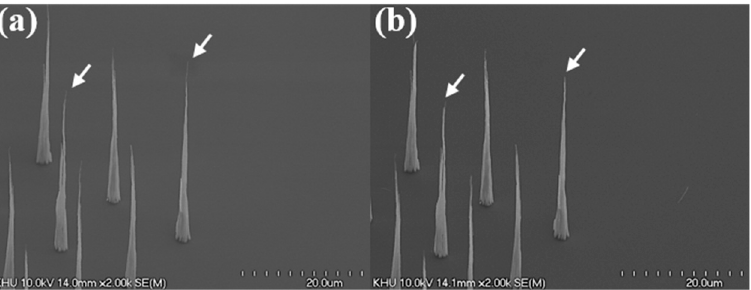
Figure 7. SEM image before and after aging. ( a ) CNT emitters before aging; ( b ) decreased CNT height (white arrow) after aging.